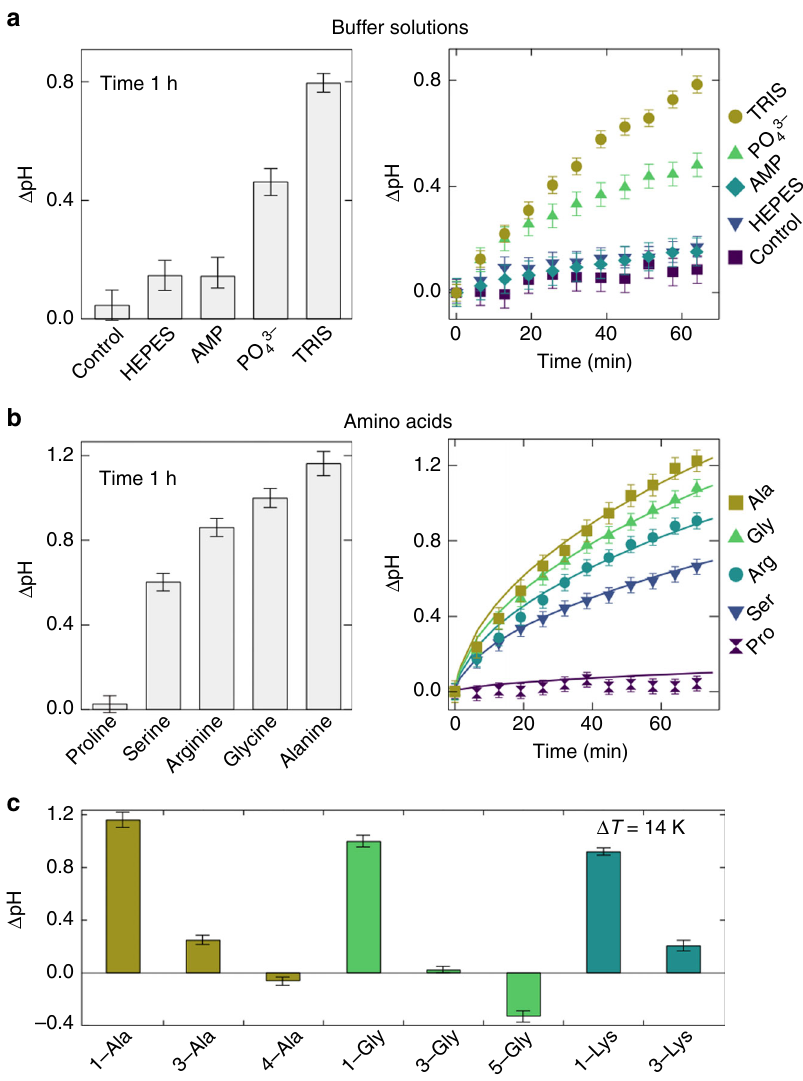
Fig. 4 Formation of proton gradients in ionic and amino acid solutions. a Various ionic solutions form steep proton gradients within 60 min, achieving Δ pH = 0.14, 0.14, 0.47, and 0.79 for HEPES, AMP, phosphate, and TRIS, respectively. As a control, the fl uorescent pH indicator SNARF-1 is dissolved in pure water, forming a pH gradient of Δ pH = 0.09. b Prebiotically plausible amino acids form proton gradients of up to Δ pH = 1.1 within 60 min. Finite-element simulations are in good agreement using differences in Soret coef fi cients Δ S T of 0.022, 0.019, 0.016, 0.012, and 0.003 K − 1 as fi tting parameters for the acceptor and donor species of alanine, glycine, arginine, serine, and proline, respectively. c Measured peptides have the tendency to form an inversed proton gradient, showing a decrease of pH at the bottom. An inversion of pH gradients is attributed to a negative difference in Soret coef fi cient Δ S T from non-ionic thermophoresis. Error bars give the standard deviation of the SNARF-1